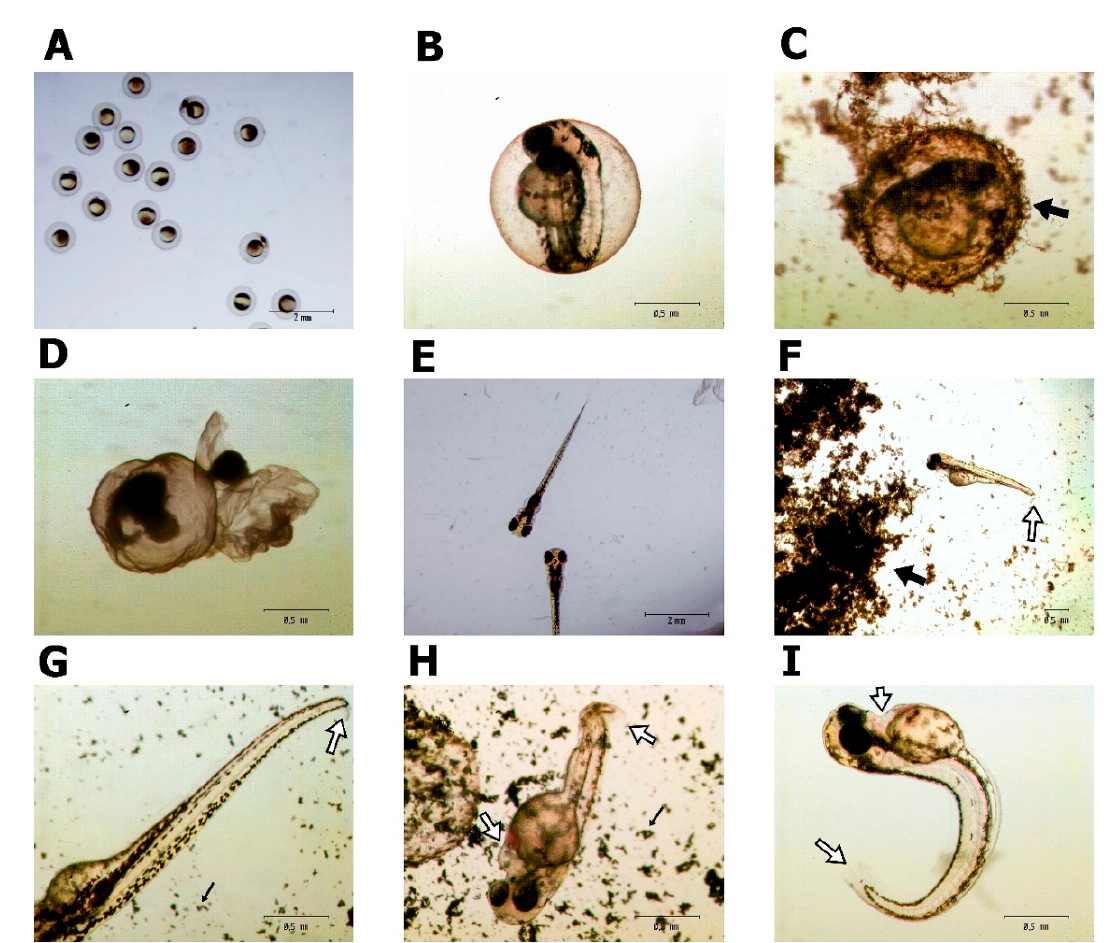
Figure 4. Danio rerio morphology after PG and GO treatment. ( A , B ) A zebrafish embryo 4 h after fertilization; ( C ) chorion covered with GO; ( D ) coagulated embryo; ( E ) properly developed embryo 96 h after fertilization, control group; ( F – I ) embryo deformities after PG ( F , H ) and GO ( G , I ) treatment. Black arrows indicate graphene agglomerates. White arrows indicate embryo deformities.